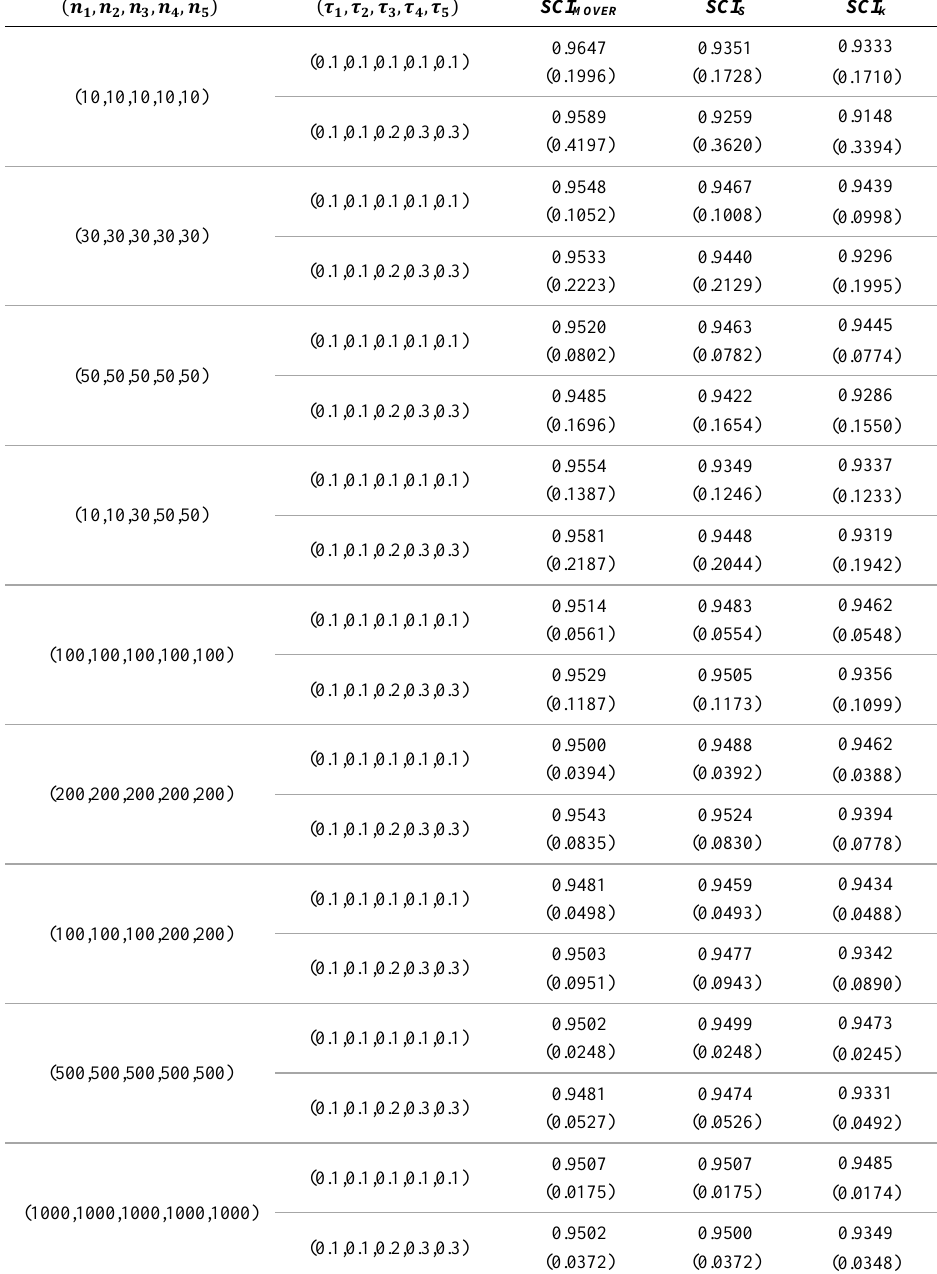
Table 2. The CP and the EL of the 95% two-sided SCIs for the means of normal distributions with known CVs: 5 sample cases (𝒏 𝟏 ,𝒏 𝟐 ,𝒏 𝟑 ,𝒏 𝟒 ,𝒏 𝟓